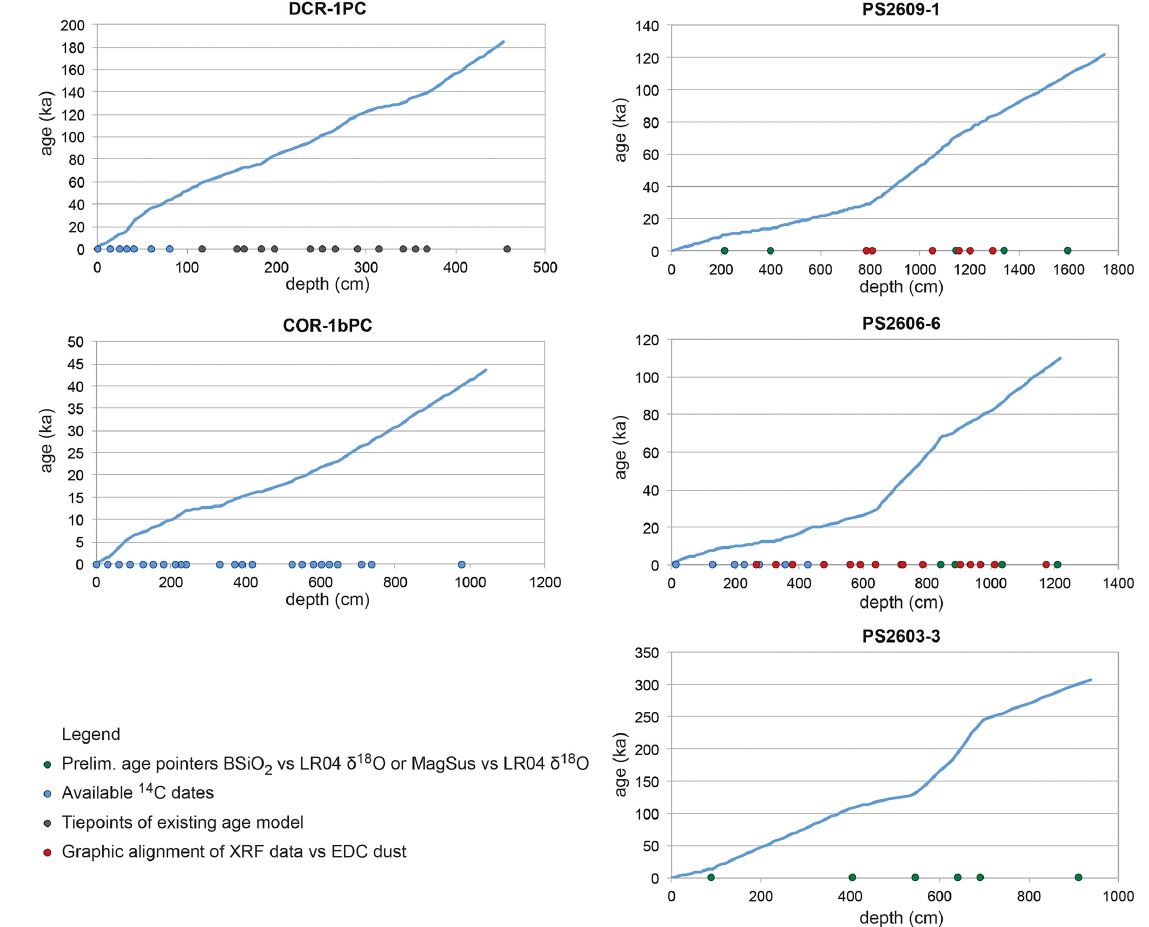
Figure 2. Age versus depth of each